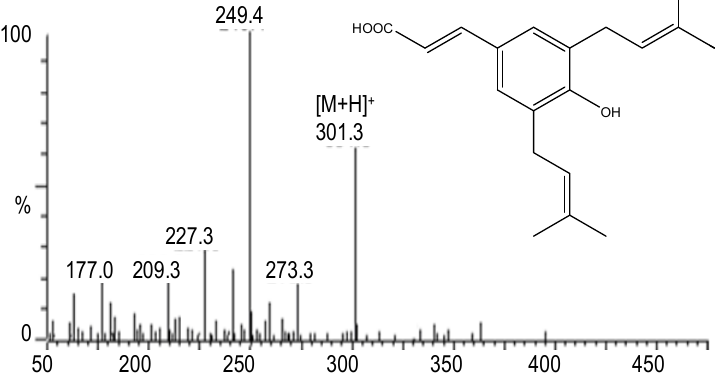
Figure 6. Mass spectra and structure of compound “c” which was identified as capillartemisin